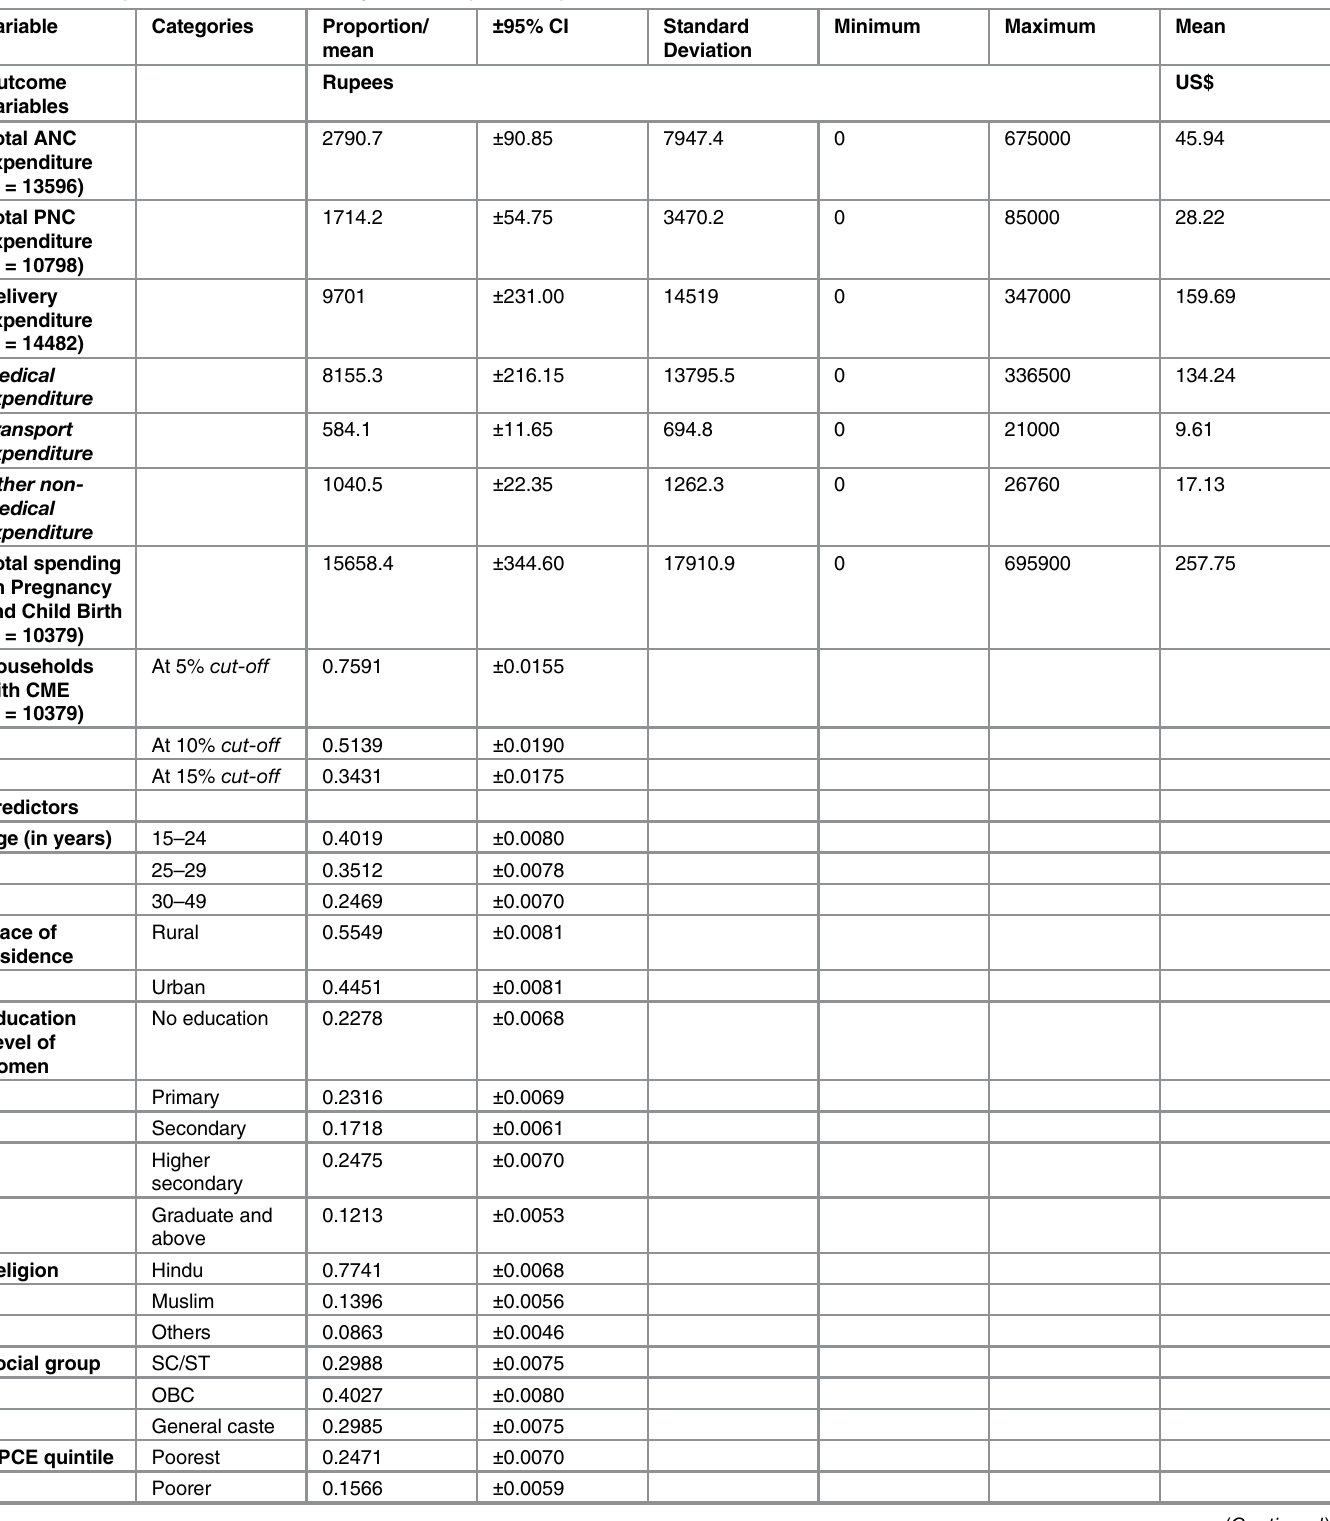
Table 1. Descriptive statistics of the study variables (n =